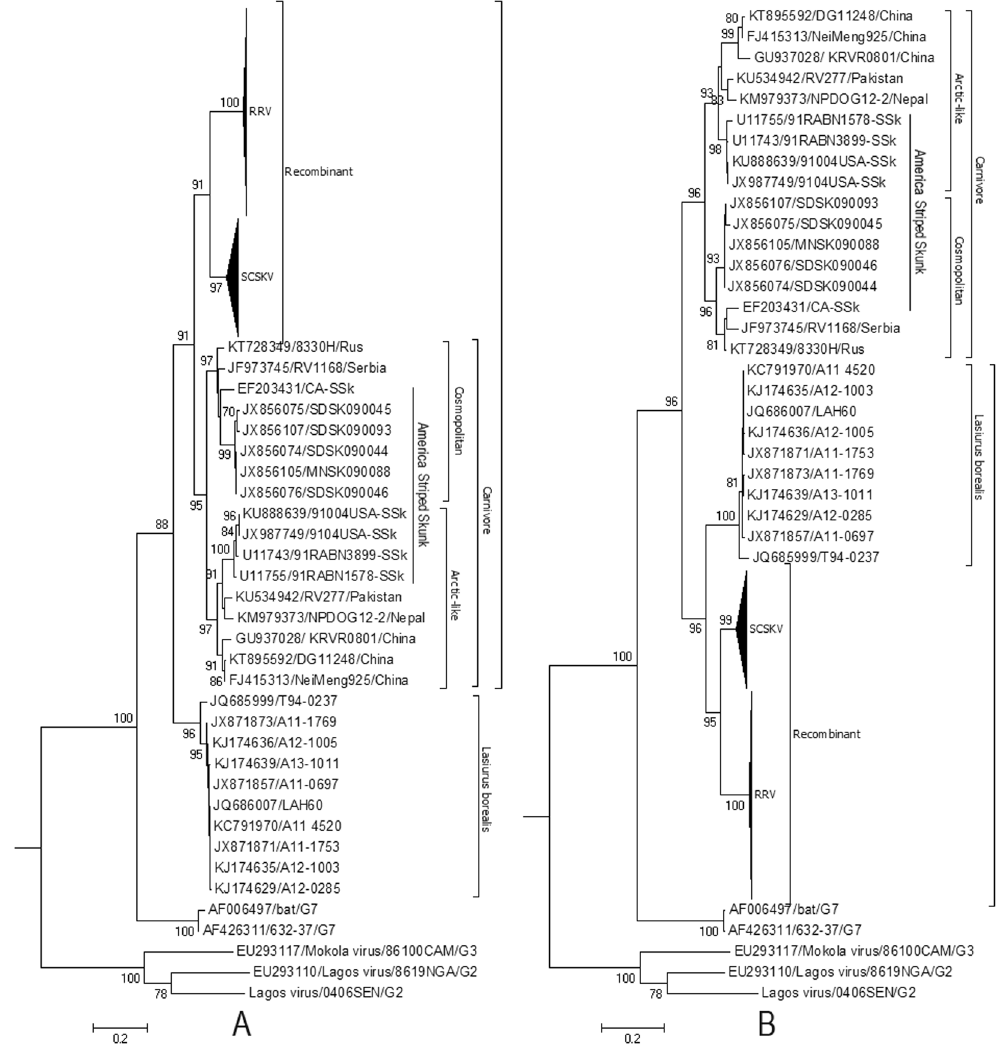
Figure 2. Phylogenetic patterns of the different regions of the G gene delimited by the putative breakpoints. ( A ) Phylogenetic history of the G gene region from positions 601 to 1347. ( B ) Phylogenetic history of G gene regions from positions 1 to 600 and 1347 to 1515 of the alignment. The evolutionary history was inferred using maximum likelihood (ML) methods. Bayesian Information Criterion within MEGA6 was used to find the best nucleotide substitution model for ML analyses. ML trees were constructed using the Tamura 3-parameter nucleotide substitution model. Among-site rate variation was gamma-distributed with invariant sites (G + I) ( A ) or gamma-distributed (G) ( B ) with four rate categories ( Γ 4). Bootstrap values ( > 70%) are listed above the branches. Evolutionary analyses were conducted in MEGA v6. G2, G3, and G7 indicate genotypes 2, 3, and 7 of Lyssavirus ; NCSK, north-central skunk; SCSK, south-central skunk; Rac, raccoon. Cosmopolitan and Arctic- like RABVs are also